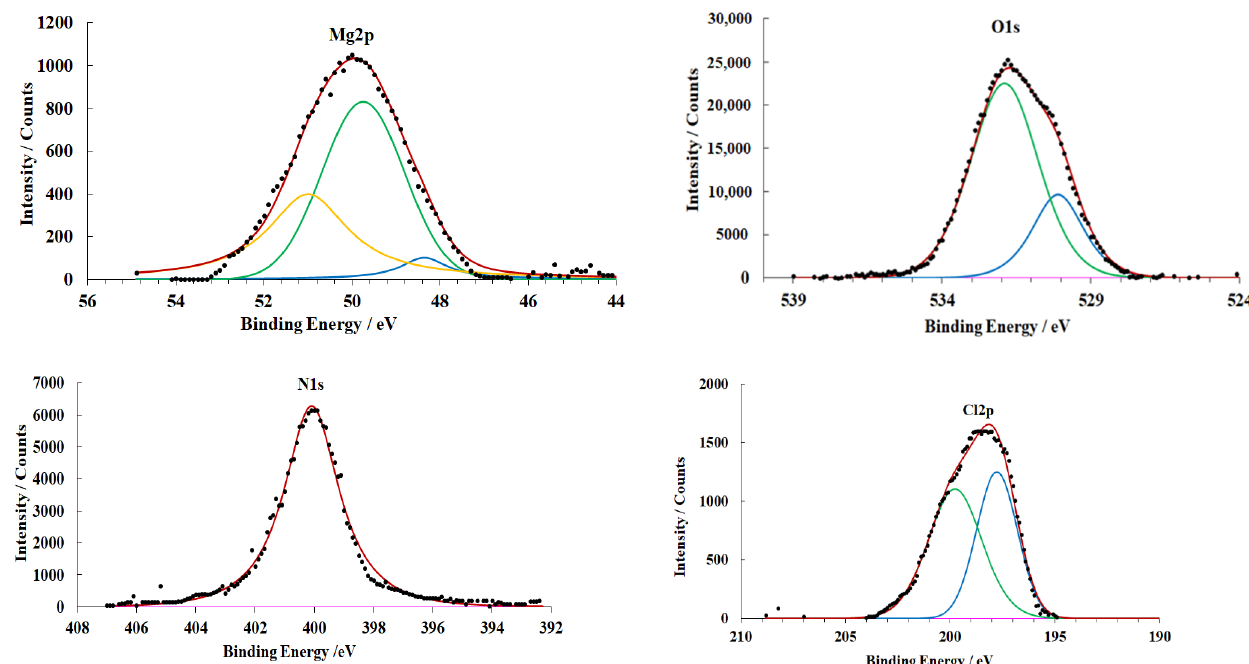
Figure 9. XPS spectra of magnesium alloy samples (preparation mode E ).